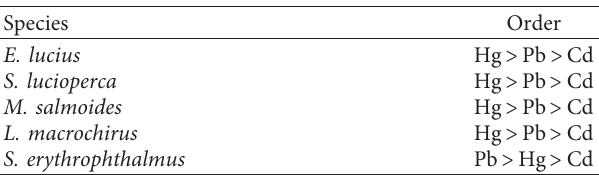
Table 7: Order of trace metals accumulated in the fish muscles from the Mechraˆa-Hammadi